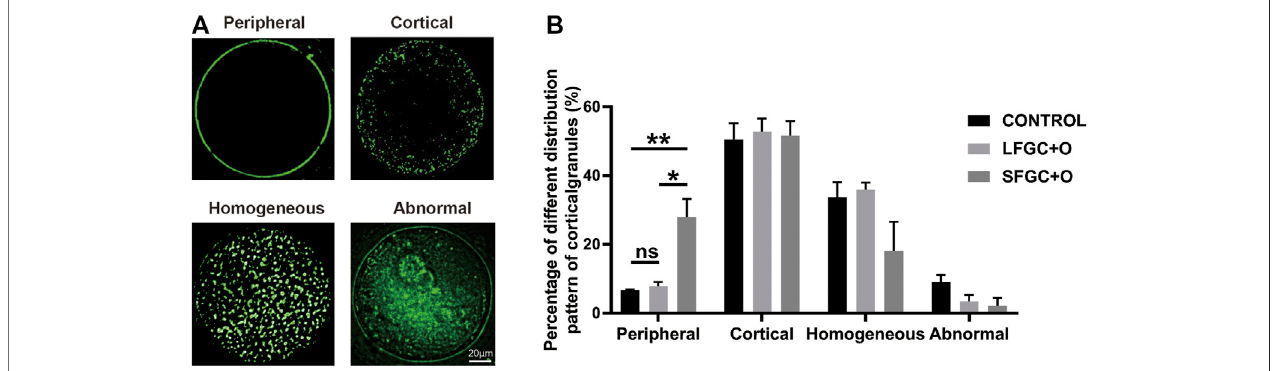
FIGURE 2 | Effects of GC co-culture on the cortical granule distribution of mare MII oocytes. (A) Cortical granule staining with RNA-FITC in mare oocytes after in vitro maturation was detected by confocal microscopy. Scale bar = 20 µm. (B) Percentages of distributions classi fi ed as peripheral, cortical, homogeneous, and abnormalforcorticalgranulesinmareMIIoocytesderivedfromtheCONTROL,LFGC-O,andSFGC-Ogroups(59oocytespergroup).Dataareshownasmeans±SEM. * p < 0.05 and ** p < 0.01.